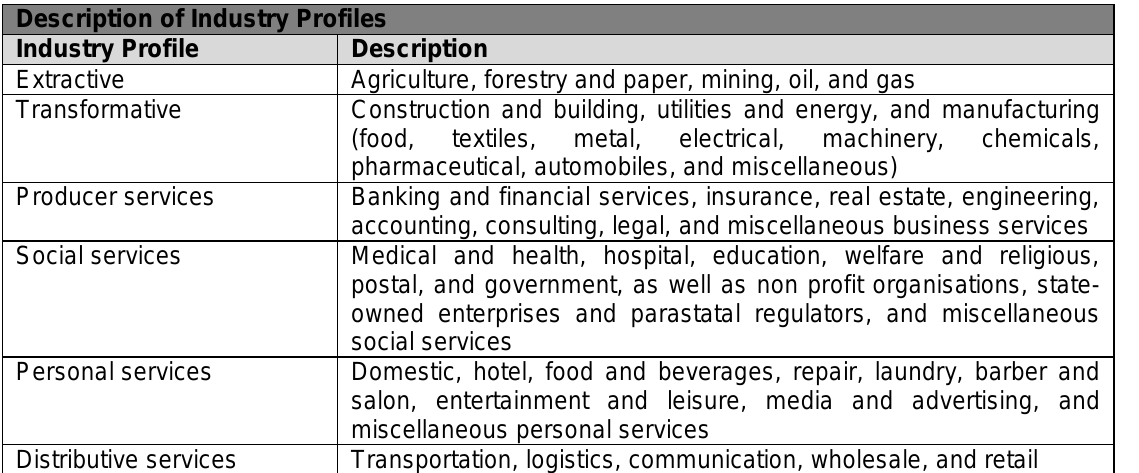
Table 2: Description of Industry